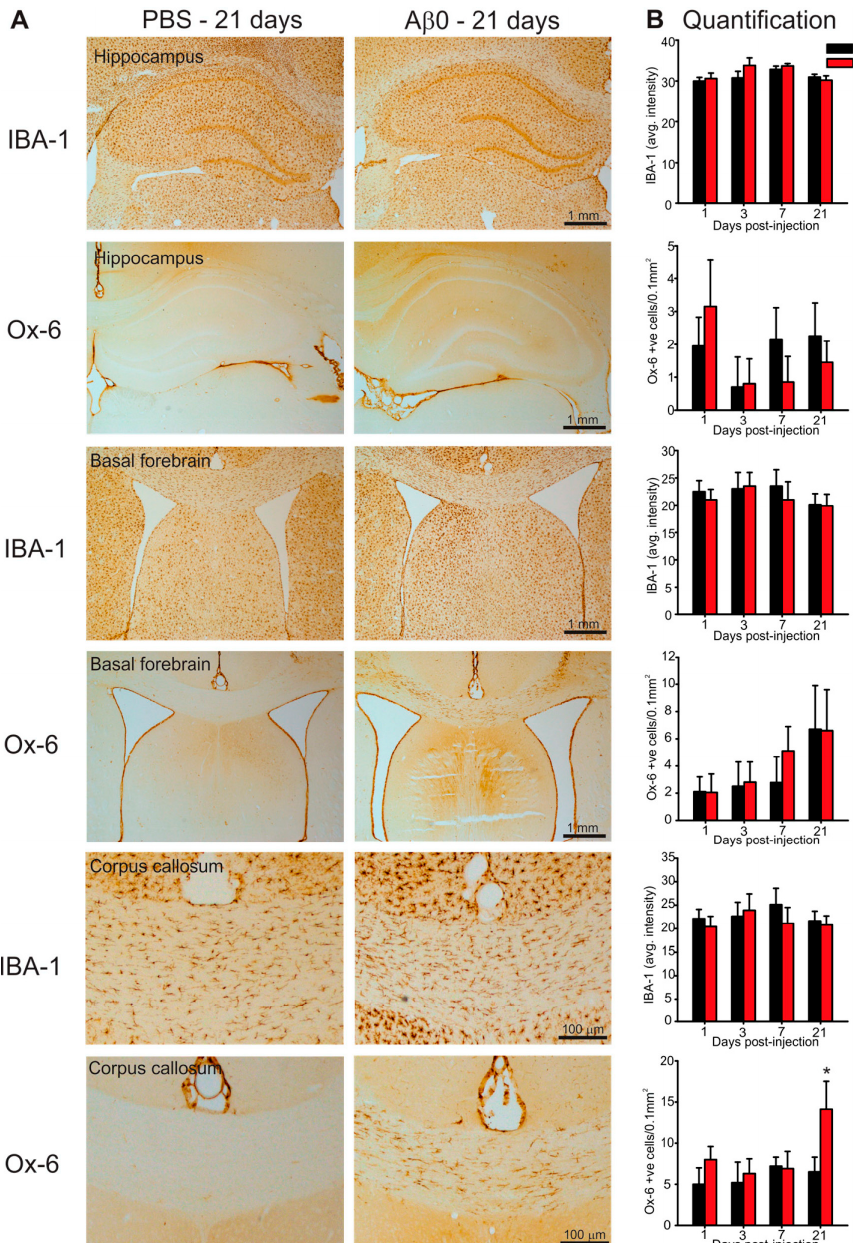
Figure 4. Microglia assessment in the hippocampus, basal forebrain and corpus callosum. Paraformaldehyde perfused rat brains were sectioned at 30 µm and stained with either IBA-1 antibody to label all microglia or Ox-6 antibody to label activated microglia in the hippocampus, basal forebrain and corpus callosum. ( A ) Photomicrographs of the hippocampus ( top two panels ) basal forebrain ( middle two panels ) and corpus callosum ( bottom two panels ) in in coronal rat brain sections from A β O-injected and PBS-injected (control) rats 21 days post-injection. Scale bars are 100 µm or 1 mm as indicated; ( B ) quantification using optical densitometry (IBA-1) or activated microglia cell counts (Ox-6) from three adjacent tissue sections per animal. No differences in IBA-1 labelling were observed between A β O-injected and controls across all brain regions. A β O-injected rats had significantly more Ox-6 positive cells within the corpus callosum compared to controls 21 days post-injection. Data presented as group means ± SEM. * indicates statistical significance between A β O-injected and control rats using 2-way ANOVA followed by Tukey’s post-hoc analysis, p < 0.05, n = 5 for each experimental group.